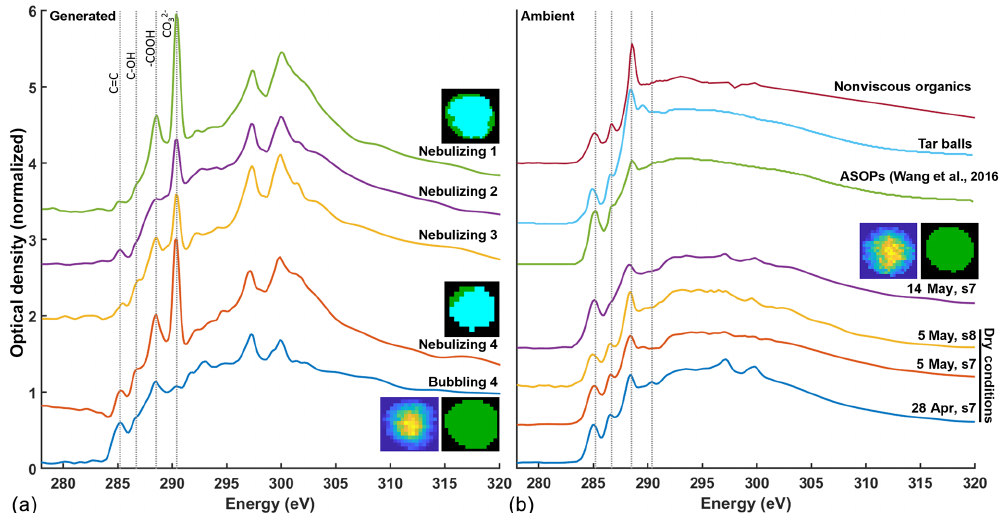
Figure 5. Comparison of NEXAFS spectra between laboratory-generated ASOP proxies (a) and four ambient ASOP samples (b) . Inset car- bon speciation maps are shown for representative particles with green representing organic-dominant regions and teal representing inorganic- dominant regions. TCA images, like the ones shown in Fig. 2, are shown as well. Only one image is shown for the ambient samples as they all look similar. The ASOP proxy spectra are show for particles generated by nebulizing aquatic samples collected at the site and by bubbling N 2 gas through one of the aquatic